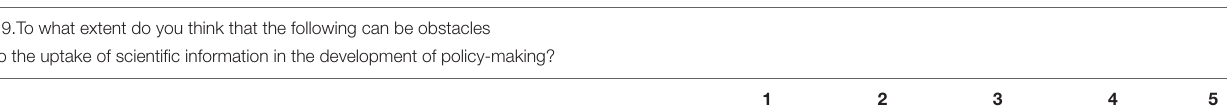
TABLE A3 | Closed-ended items used in policymakers’ views questionnaire